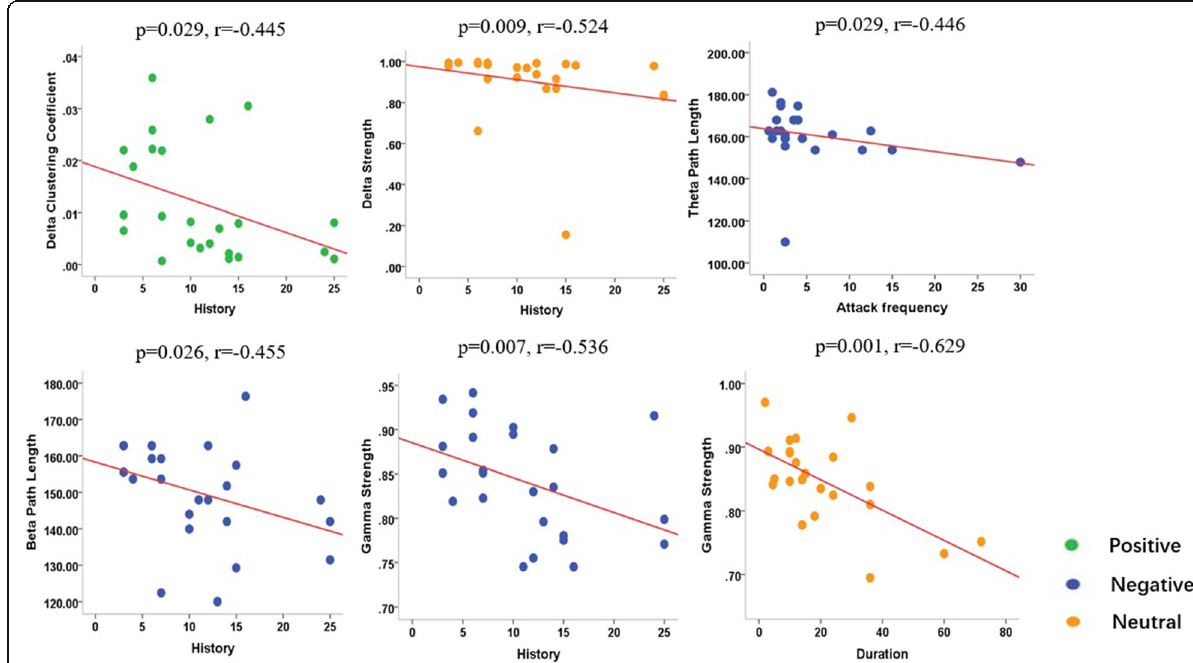
Fig. 6 Charts of Spearman ’ s correlation, showing significant correlations between the parameters of network and clinical characteristics in the migraine patients in viewing the positive emotional stimuli (green point), negative emotional stimuli (blue point), and neutral stimuli (orange point). During positive emotion stimuli, the migraine history showed a negative correlation with C in the delta frequency. During negative emotion stimuli, the history of migraine showed a negative correlation with L in the beta band and with S in the gamma band, and the attack frequency of migraine also showed a negative correlation with L in the theta band. During the neutral emotion stimuli, the migraine history and duration showed a negative correlation with S in the delta and gamma frequencies,